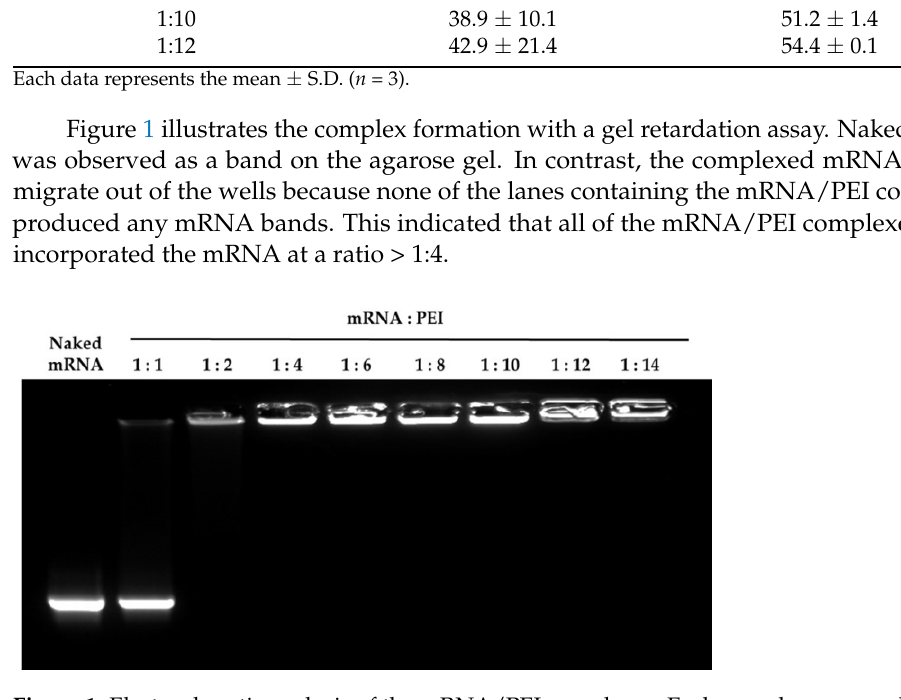
Figure 1. Electrophoretic analysis of the mRNA/PEI complexes. Each complex was applied to an agarose gel and subjected to electrophoresis. Retardation of the mRNA was visualized using